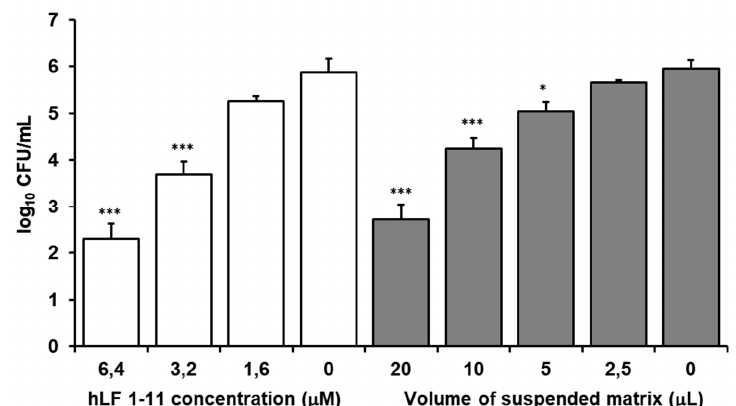
Figure 5. Activity of hlF 1-11 against S. epidermidis : cell viability after 1 h of incubation at 37 °C. Activity of the peptide alone at different concentrations and of the peptide released by different volumes of matrices. Statistical significance in each group in comparison with the bars without peptide (Mean ± SE, n = 5); (*** p ≤ 0.001, * p ≤